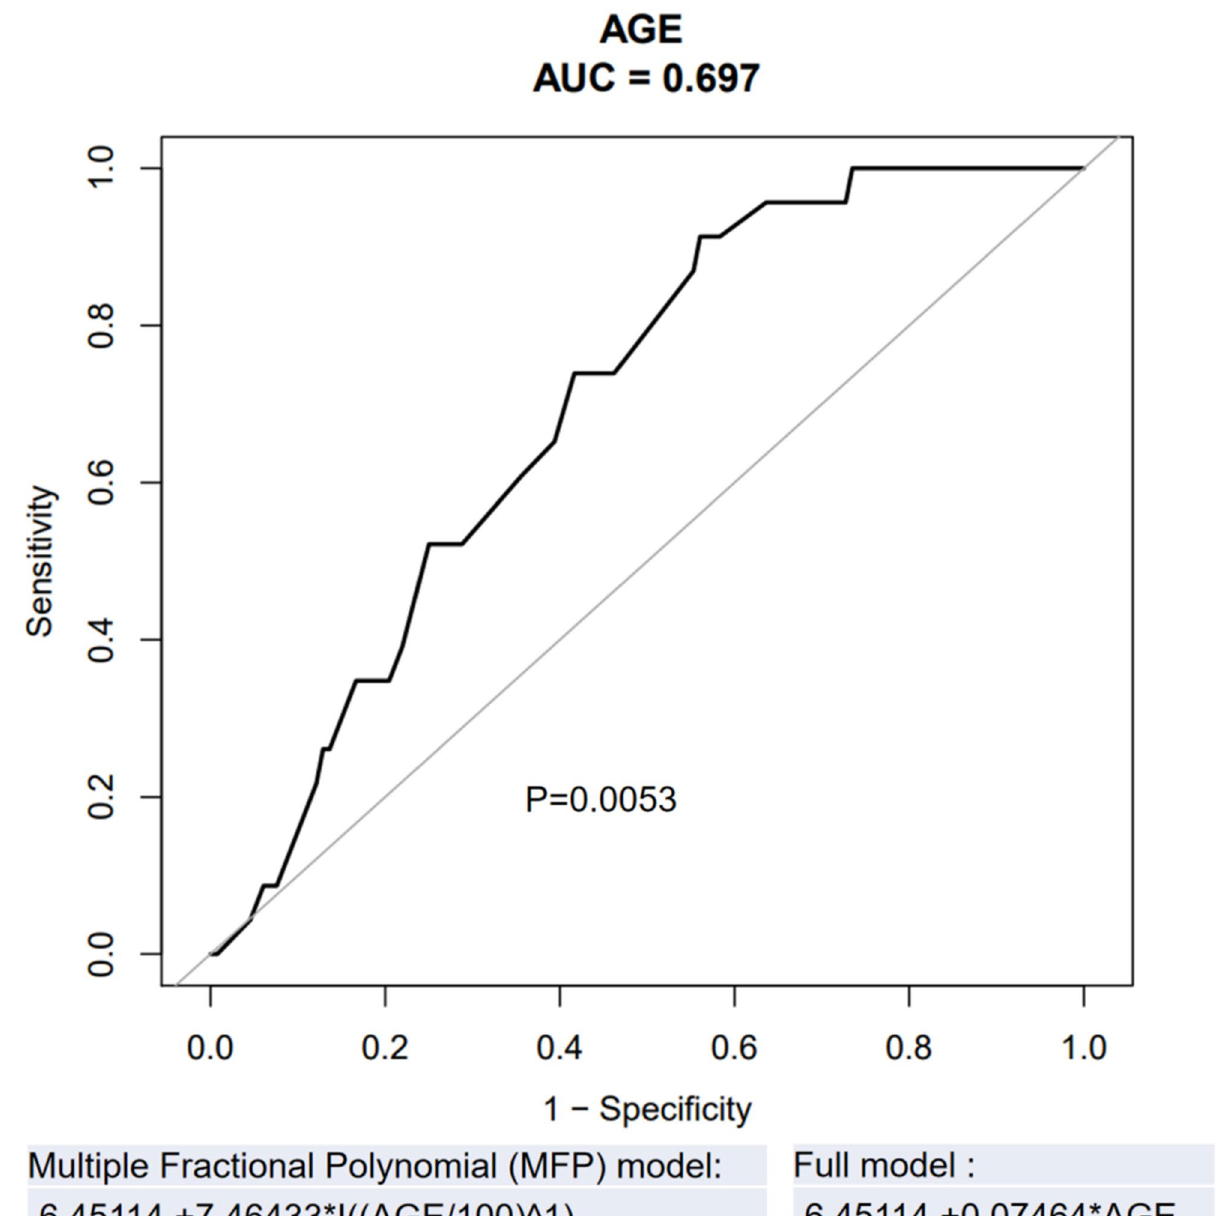
Figure 3. Predictive model and the ROC curve (created by Empower Stats and R software, www. empow ersta ts. com; http:// www.R- proje ct) analysis for age and baseline peripheral neuropathy (AUC = 0.697; p = 0.0053). Multiple Fractional Polynomial (MFP) model: − 6.45114 + 7.46433 × I((AGE/100) 1 ). Full model: − 6.45114 + 0.07464 ×